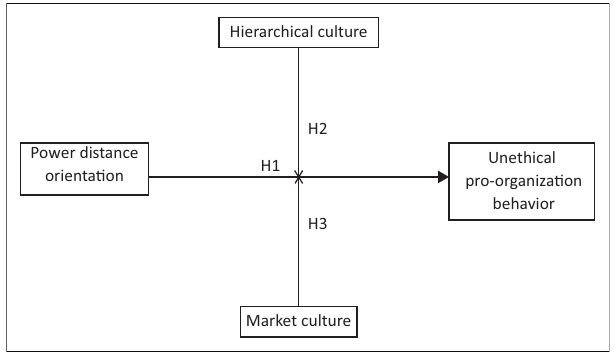
FIGURE 1: Research model and hypotheses.